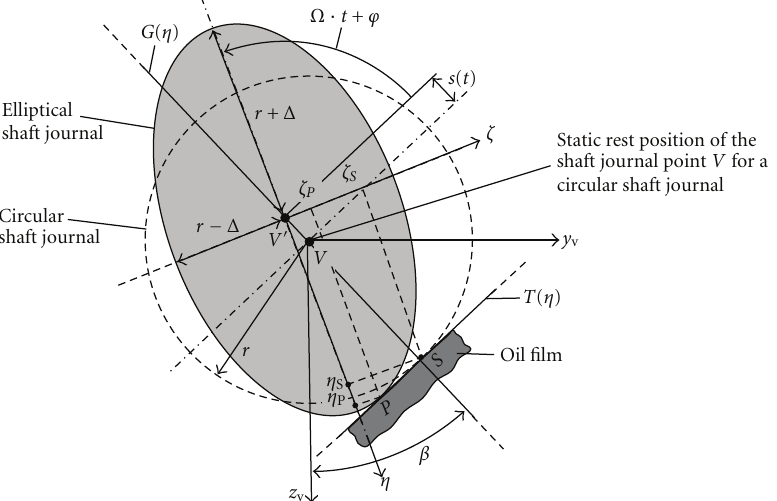
bearing shell B . So if a displacement of the bearing